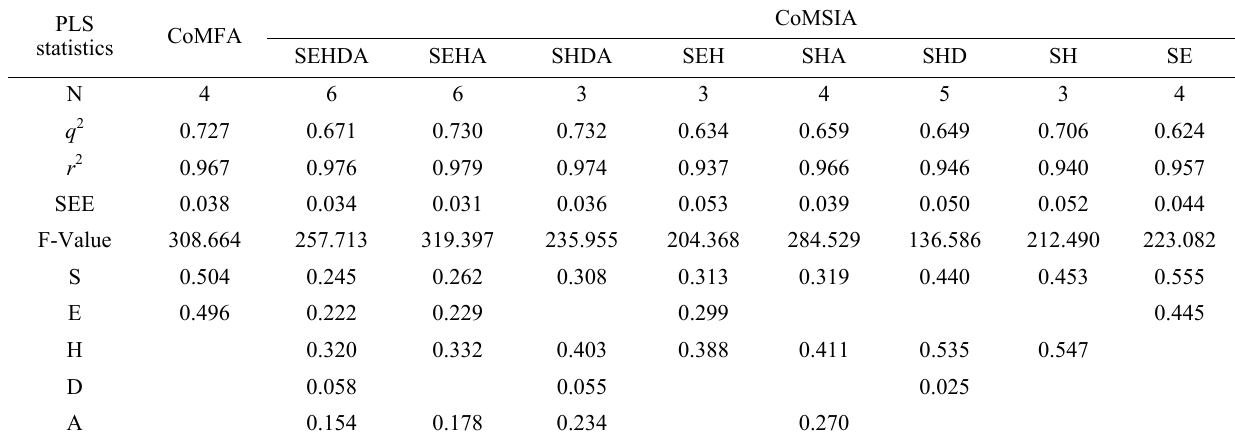
Table 1 PLS statistics of CoMFA and CoMSIA models using combinations of the five field descriptors.